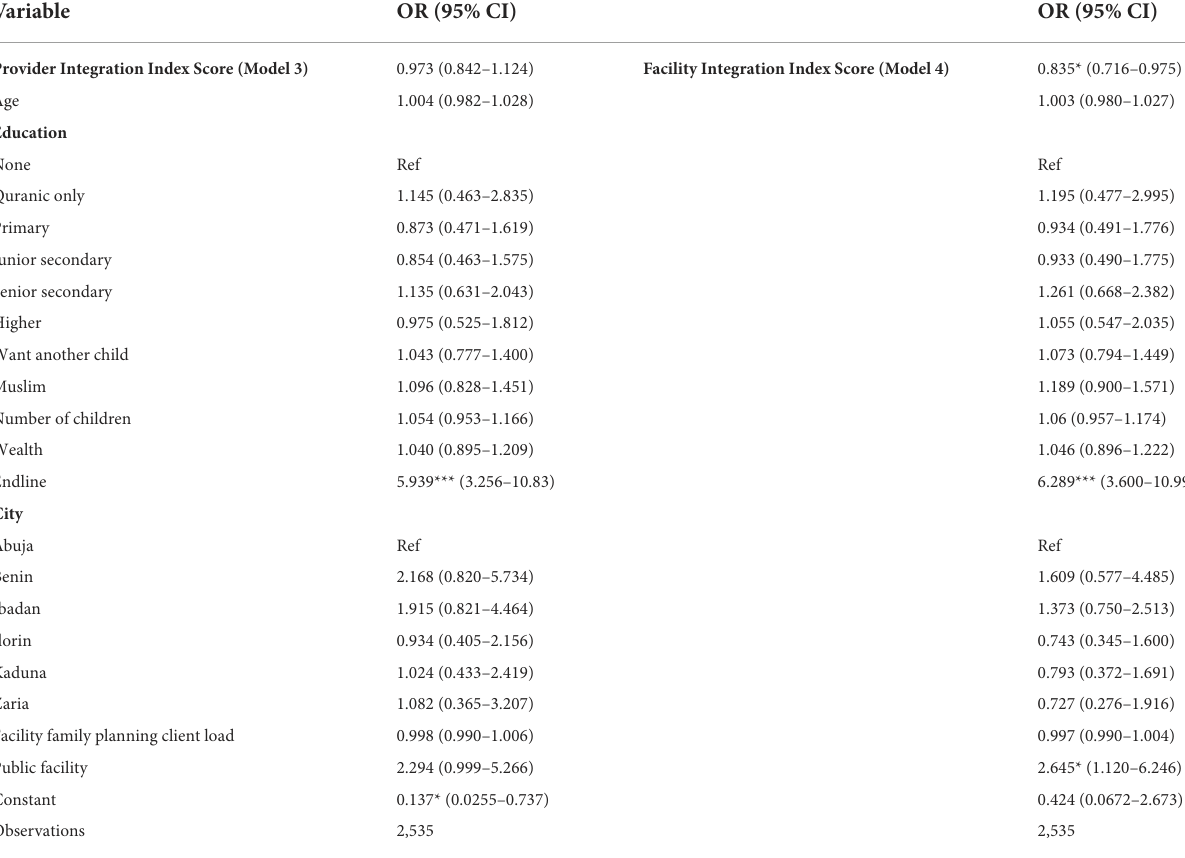
TABLE 3 Association between provider and facility integration index scores and receipt of family planning information during immunization visit.